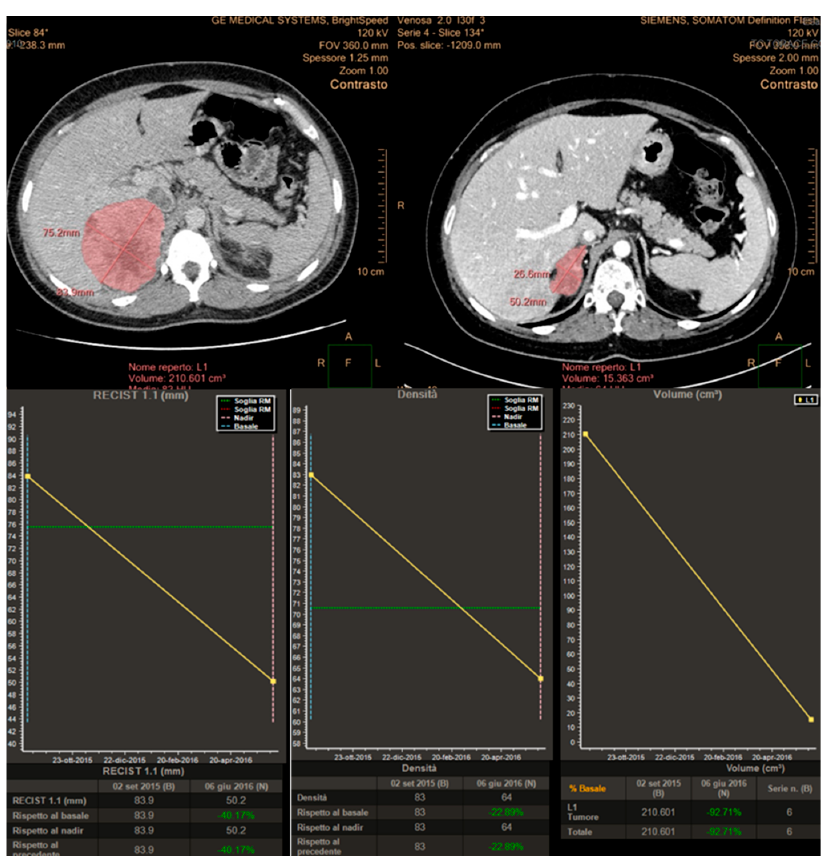
Figure 8. Analysis of variations of tumor characteristics (longest diameters for RECIST 1.1, attenuation changes for Choi and Volume changes) obtained after semi-automatic tumor segmentation and displayed in a chart using the “Multimodality Tumor Tracking” Software (IntelliSpace Portal-Philips).